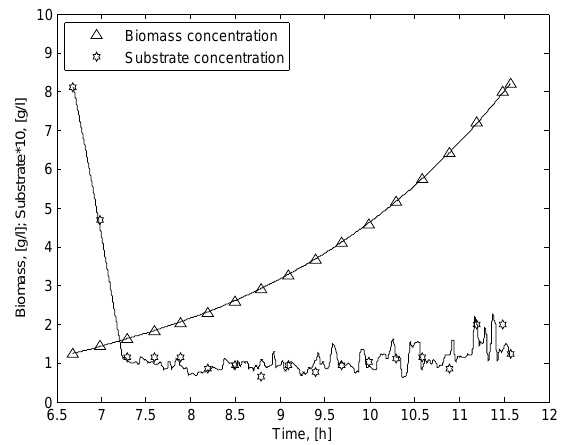
Fig. 2. Biomass and substrate concentration - modelled and real experimental data